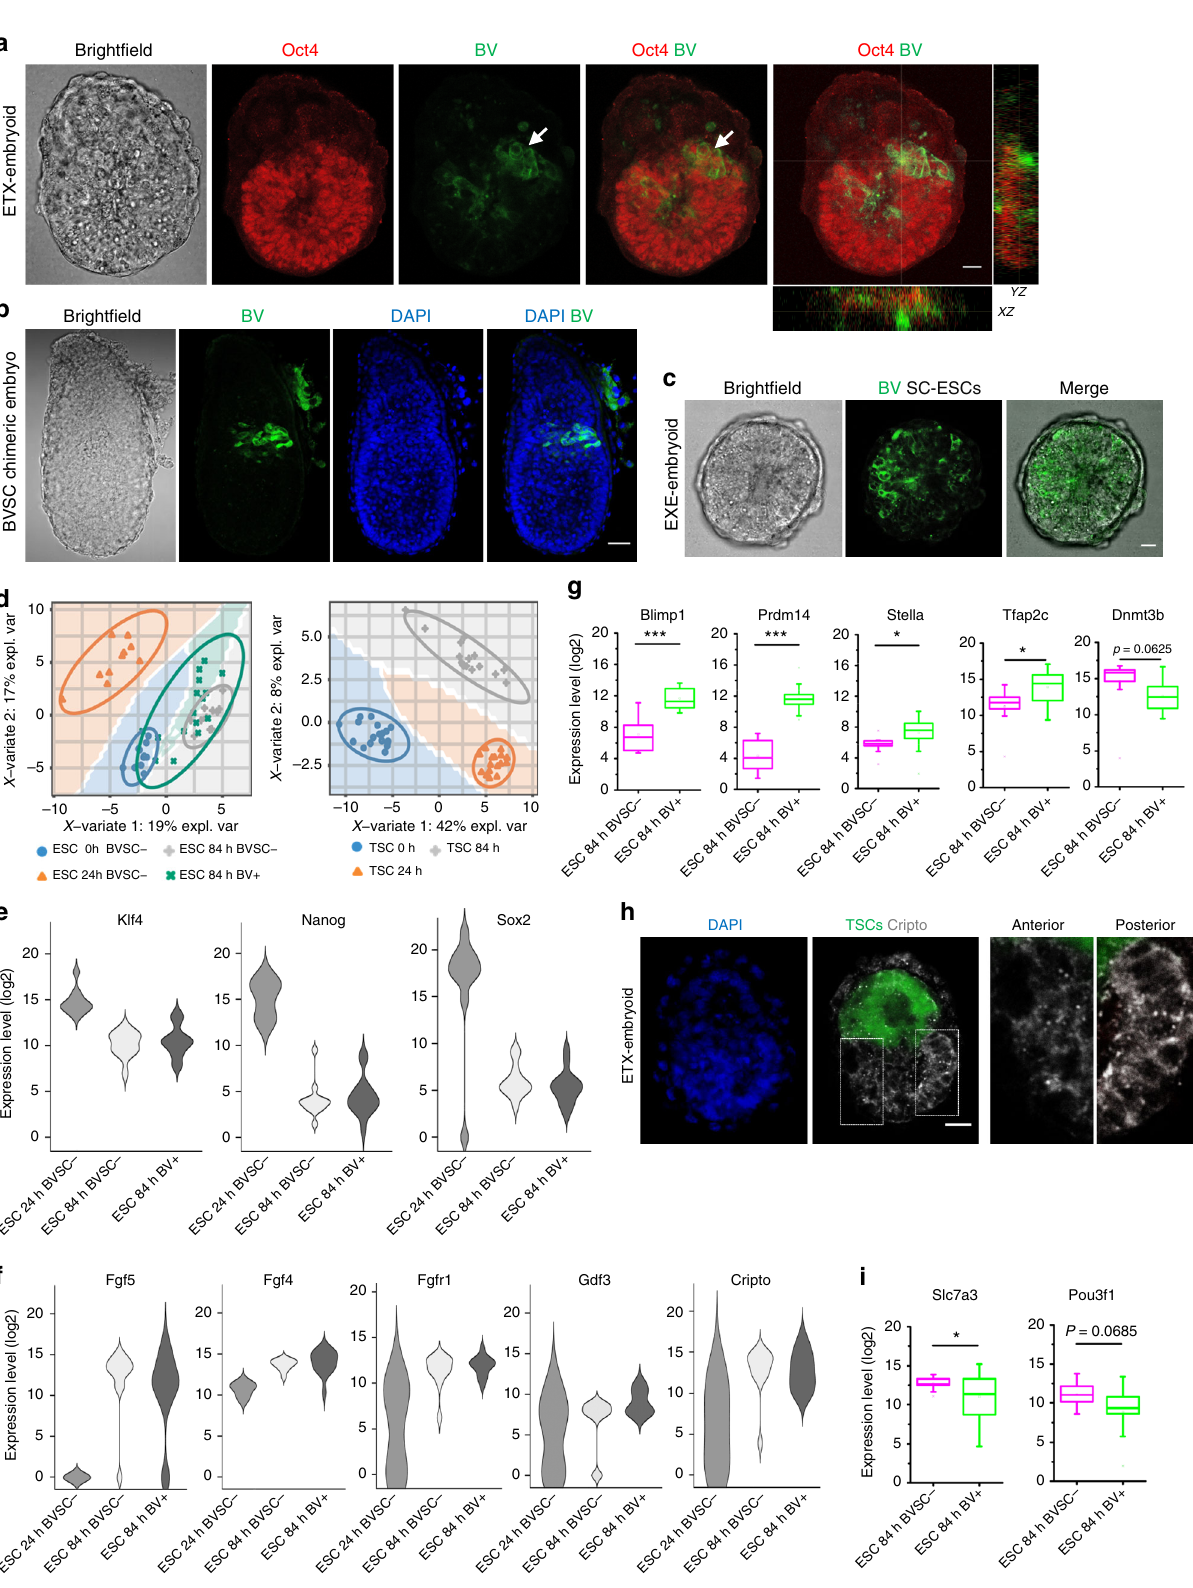
ment in ETX-embryoids.